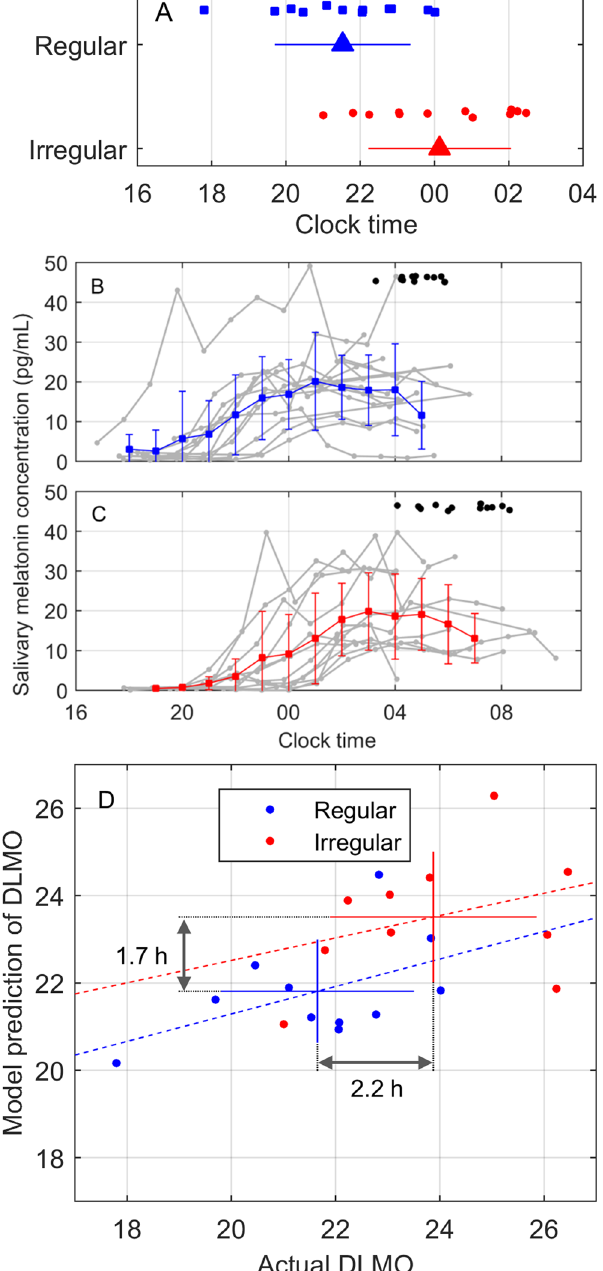
Figure 3. Melatonin secretion is delayed in Irregular sleepers. Top panel: ( A ) Timing of salivary dim light melatonin onset (DLMO) for Regular ( n = 12) and Irregular ( n = 12) groups. Individuals in each group are shown as dots, with y-axis position jittered for visibility. Groups means (triangles) and standard deviations (error bars) are shown. Middle two panels: Time course for salivary melatonin concentration are shown for Regular participants in ( B ) and Irregular participants in ( C ), along with average sleep midpoint times for the nighttime sleep block for each individual (black dots), with y-axis position jittered for visibility. Gray lines show individuals in 1-h bins. Colored lines with error bars show group mean and standard deviation in 1-h bins. Bottom panel: ( D ) Actual timing of DLMO vs. model prediction for timing of DLMO, assessed using saliva. Data points correspond to individuals in the Regular (blue square) and Irregular (red circle) groups. Error bars show mean and standard deviation for each group. Differences in group averages are displayed. The dashed lines show linear regressions for each